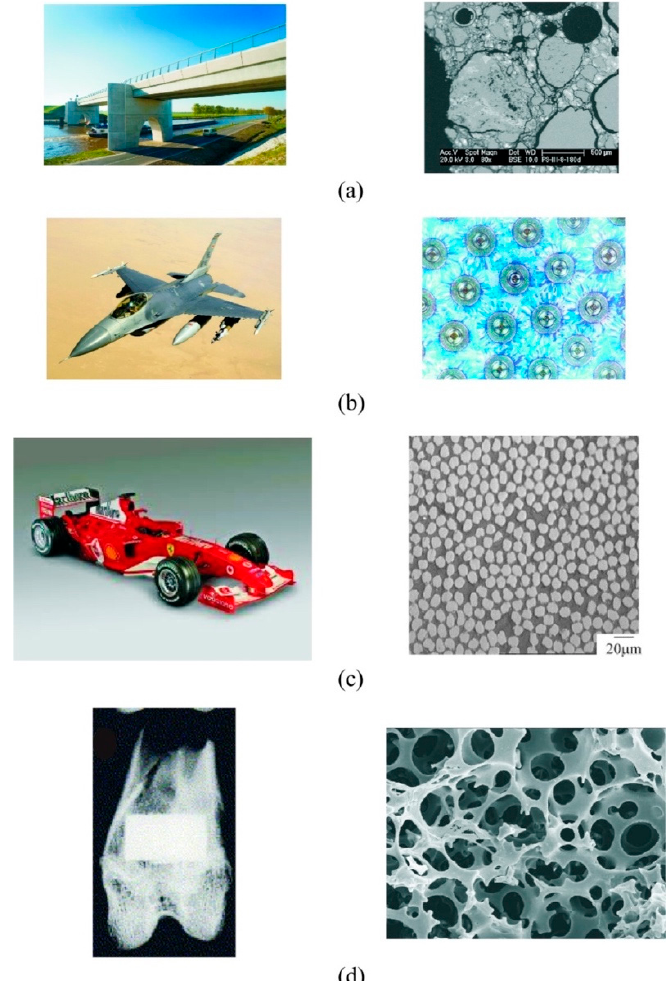
Figure 3. Artificial materials with a microstructure. Left pictures are referred to the human (~m) scale (usually referred as the macroscopic or coarse scale) while right ones correspond to a higher observation (~ μ m) scale (usually referred as the microscopic or finer scale). ( a ) (left) Concrete bridge (Picture taken from www.wikipedia.org) and (right) typical microstructure of a concrete building material (Picture taken with permission from [28]). ( b ) (left) F-16 Fighting Falcon aircraft. It uses monofilament silicon carbide fibers in a titanium matrix for a structural component of the jet's landing gear (microstructure shown in right) (Picture taken from www.wikipedia.org). ( c ) (left) Ferrari F-1 prototype. Many parts of the structure are made of fiber carbon composite (Picture taken from www.wikipedia.org); right Microstructure of a carbon finer reinforced composite (Picture taken with permission from [34]). ( d ) (left) Bioceramic implant to promote new bone tissue regeneration in Tissue Engineering process. The implant is microstructurally featured in right. It is a porous scaffold where cells attach, segregate new matrix and finally new bone tissue regeneration. (Picture ( d ) (left) taken with permission from [35] and (right) taken with permission from [36]).